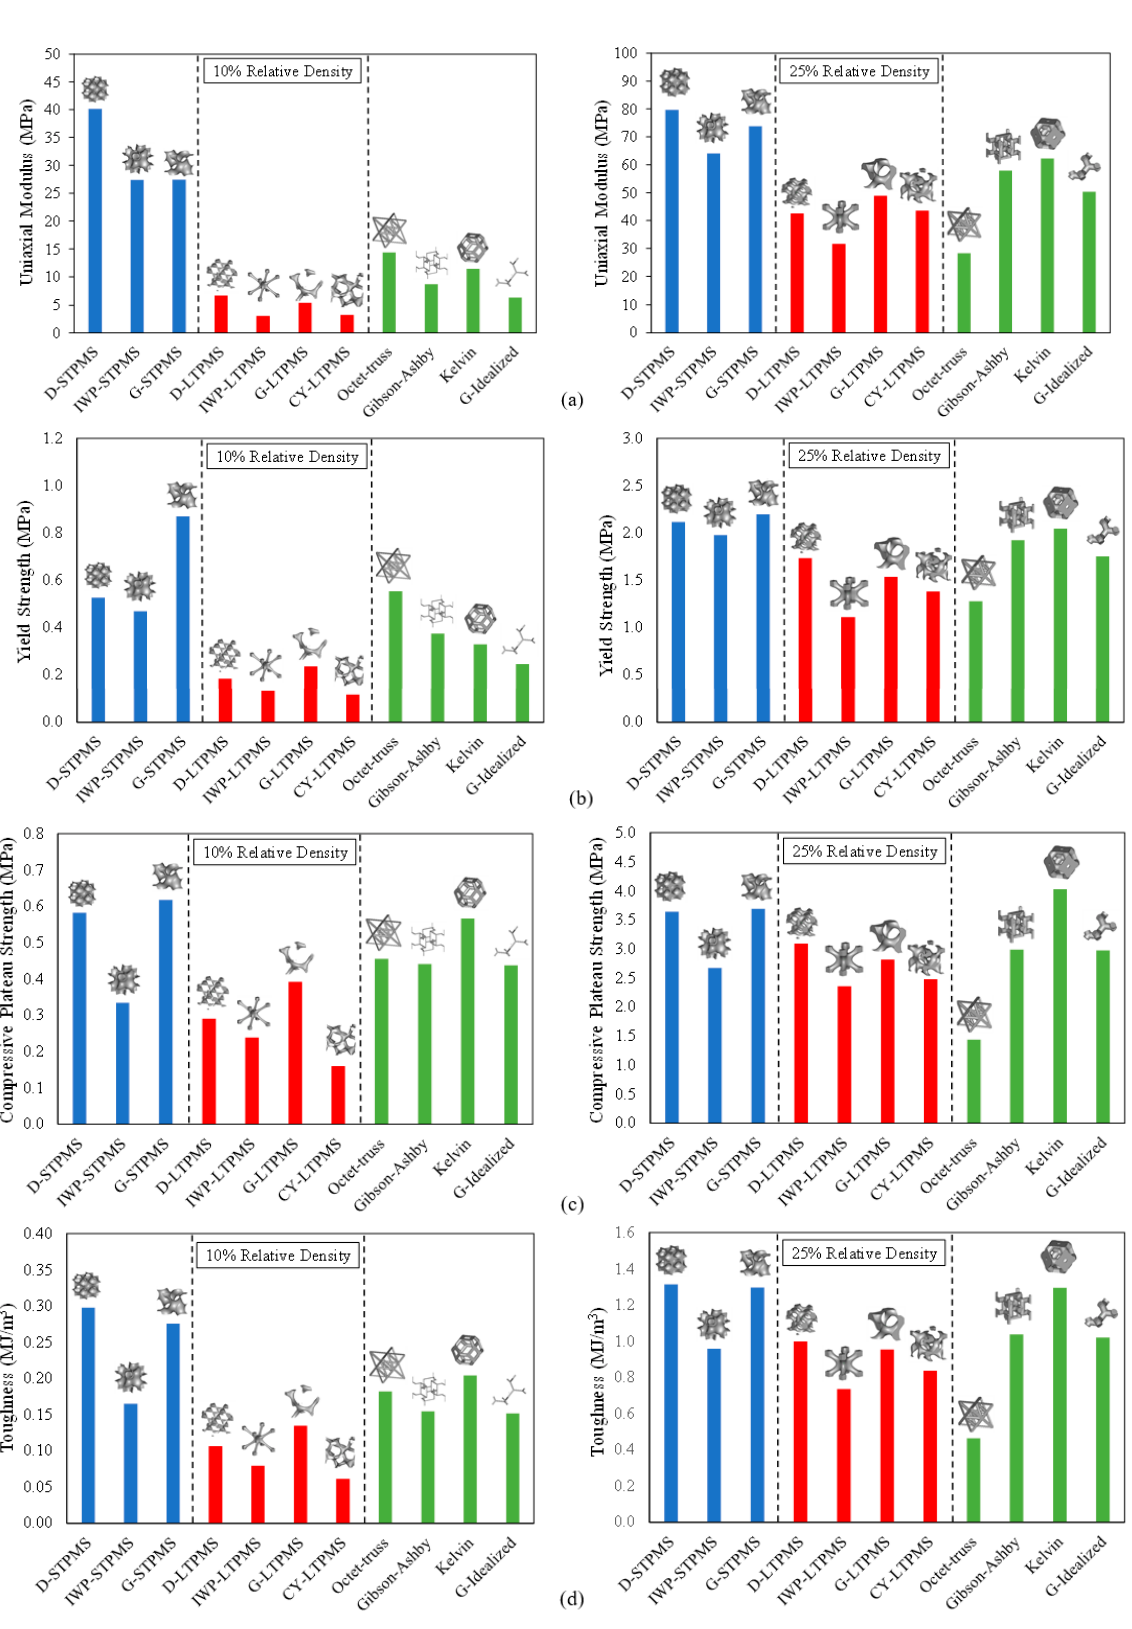
Figure 9. Compressive mechanical properties at 10% and 25% relative densities. ( a ) Uniaxial modulus, ( b ) yield strength, ( c ) plateau strength, and ( d ) toughness.